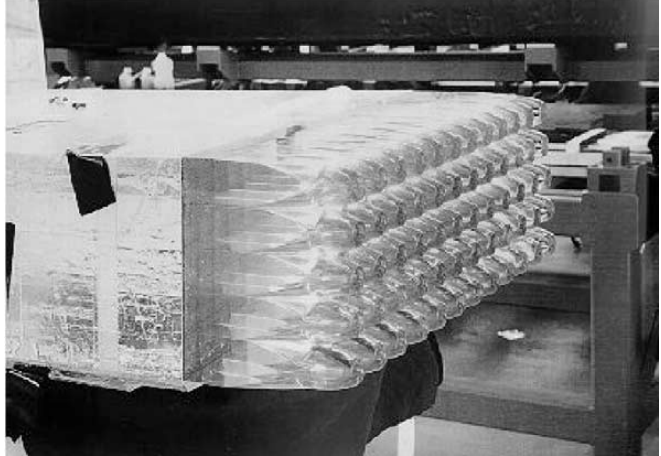
Figure 119. Light guides at one end of a barrel module before the installation of the phototubes. The layout of the calorimeter inside the KLOE magnet is depicted in Figure 120.